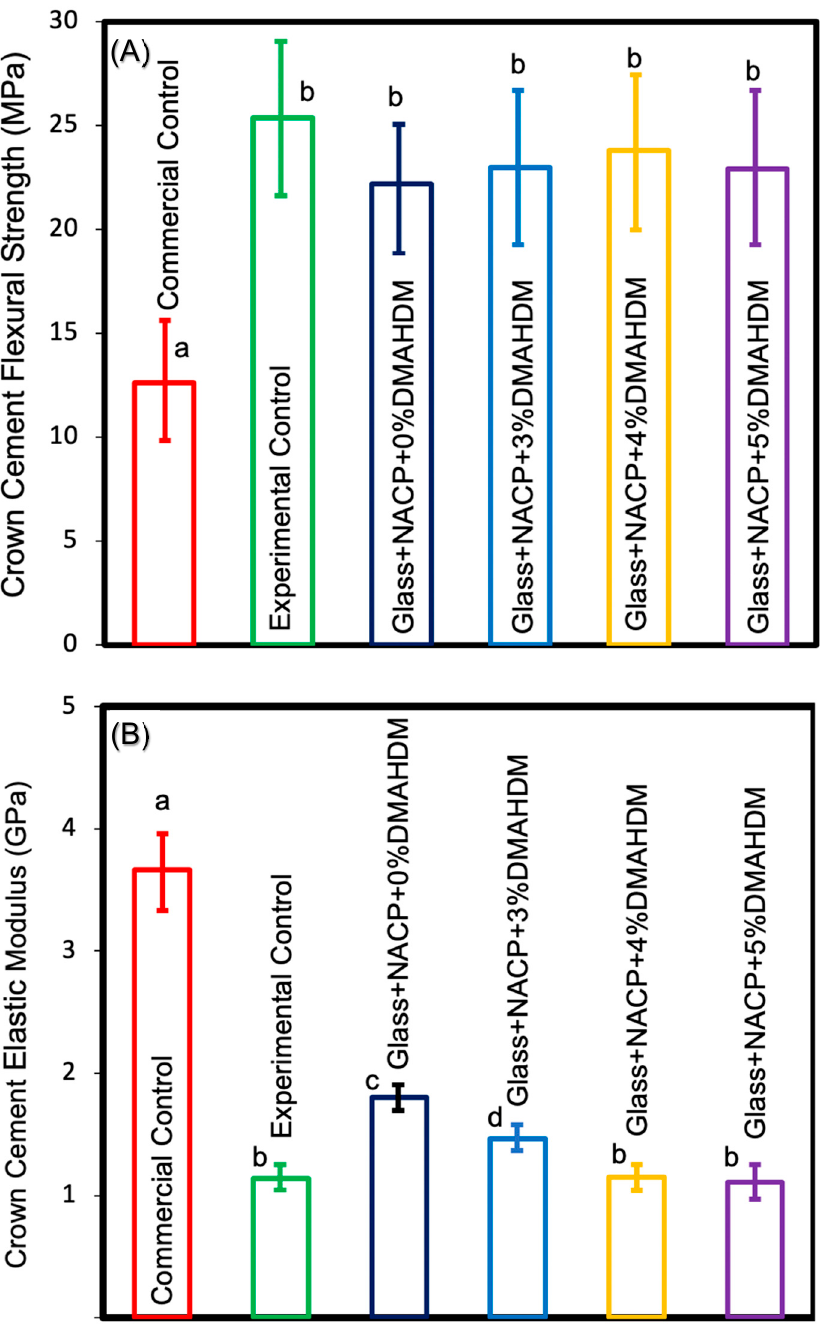
Figure 3. ( A ) Flexural strength and ( B ) elastic modulus (mean ± SD; n = 10). Adding 3%, 4%, and 5% DMAHDM combined with 25% NACP resulted in higher flexural strength values compared to the commercial control ( p < 0.05). The incorporation of 4% and 5% DMAHDM combined with 25% NACP in the resin cement resulted in comparable elastic modulus values to the experimental control ( p > 0.05). The incorporation of 25% NACP and 3% DMAHDM combined with 25% NACP in the resin cement resulted in higher elastic modulus values compared to the experimental control ( p > 0.05). The elastic modulus values of the commercial control group were significantly greater than all other groups ( p < 0.05). Values indicated by different letters are statistically different from each other ( p < 0.05).